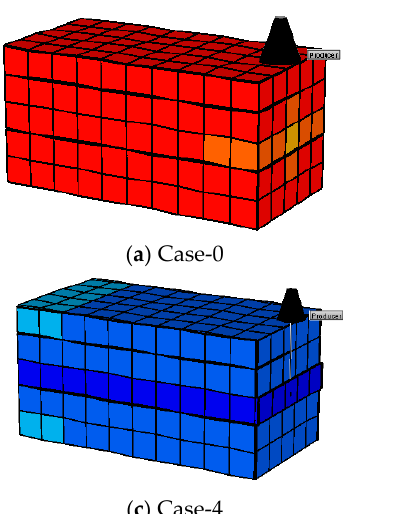
Figure 9. Pressure comparison between different scattered fractures in the depletion process.